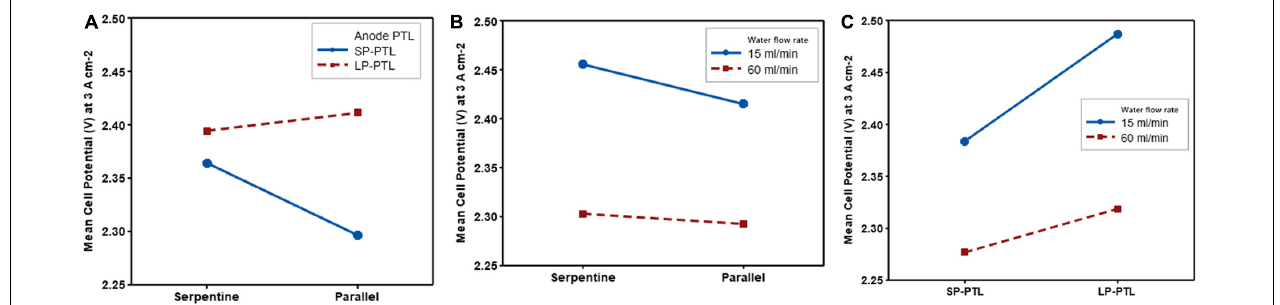
FIGURE 7 | Interaction plots (anode flow-field design, anode PTL and water flow rate). (A) Interaction plot of anode PTL and anode flow-field design. (B) Interaction plot of water flow rate and anode flow-field design. (C) Interaction plot of water flow rate and anode